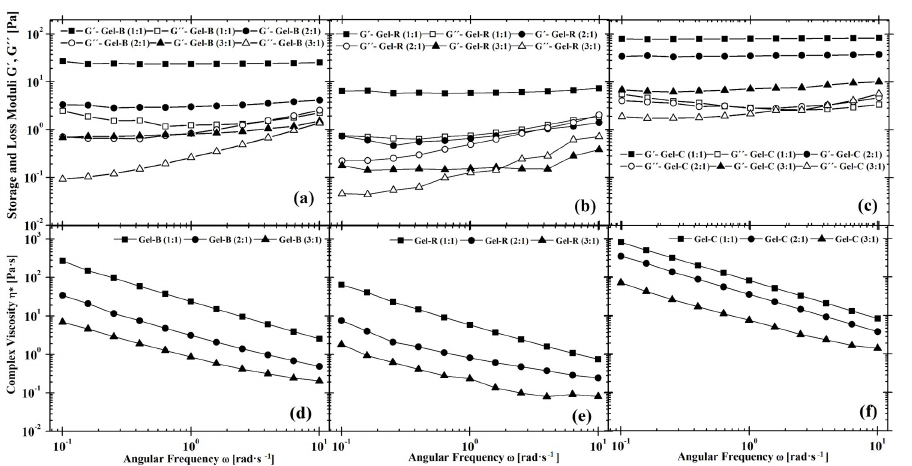
Figure 2. The angular frequency-dependent viscoelastic moduli ( a–c ) and complex viscosity ( d–f ) for Gel-based hydrogels: ( a , d ) Gel-B, ( b , e ) Gel-R, and ( c , f ) Gel-C for all examined Gel:Dex-Ox